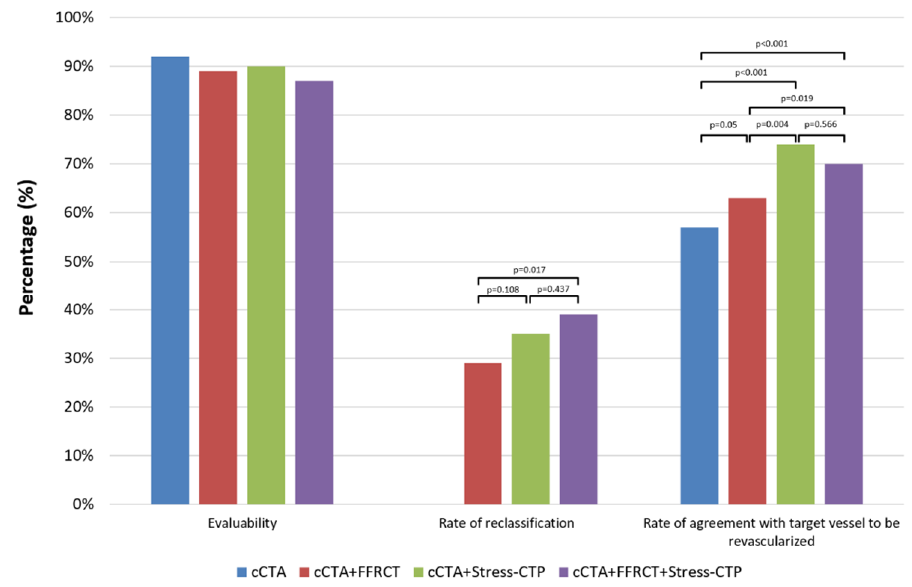
Figure 7. Secondary endpoints of the study between di ff erent diagnostic strategies. No di ff erences were found in terms of evaluability between the di ff erent strategies. Both the cCTA + Stress-CTP and cCTA + FFR CT + Stress-CTP strategies showed a higher rate of patient reclassification and rate of agreement for the target vessel to be revascularized as compared to cCTA alone and the cCTA + FFR CT strategy. cCTA: coronary computed tomography angiography; Stress-CTP: stress computed tomography perfusion; FFR CT : computed tomography-derived fractional flow reserve.